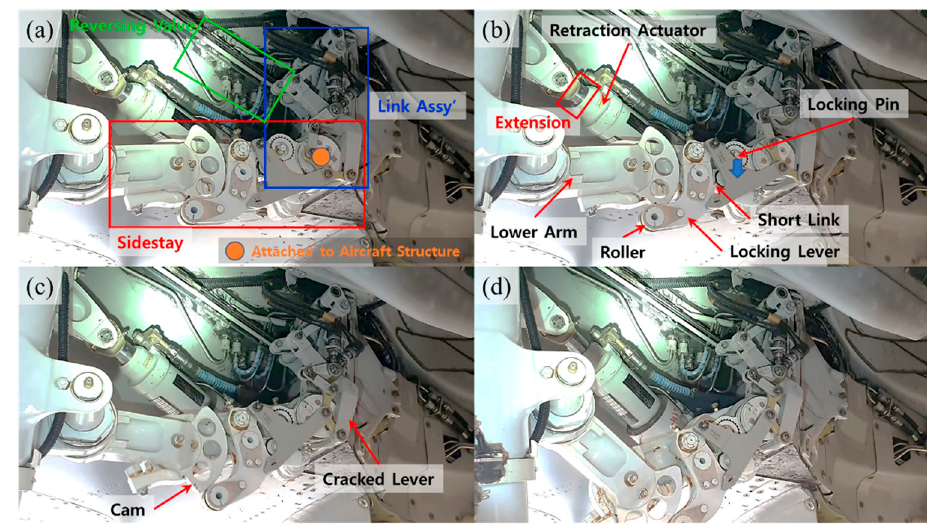
Figure 3. Hawker 800XP aircraft main landing gear sidestay, link assembly, and reversing valve in ( a ) Down Lock state, ( b , c ) initial unlock state, and ( d ) Moving Up state [17].